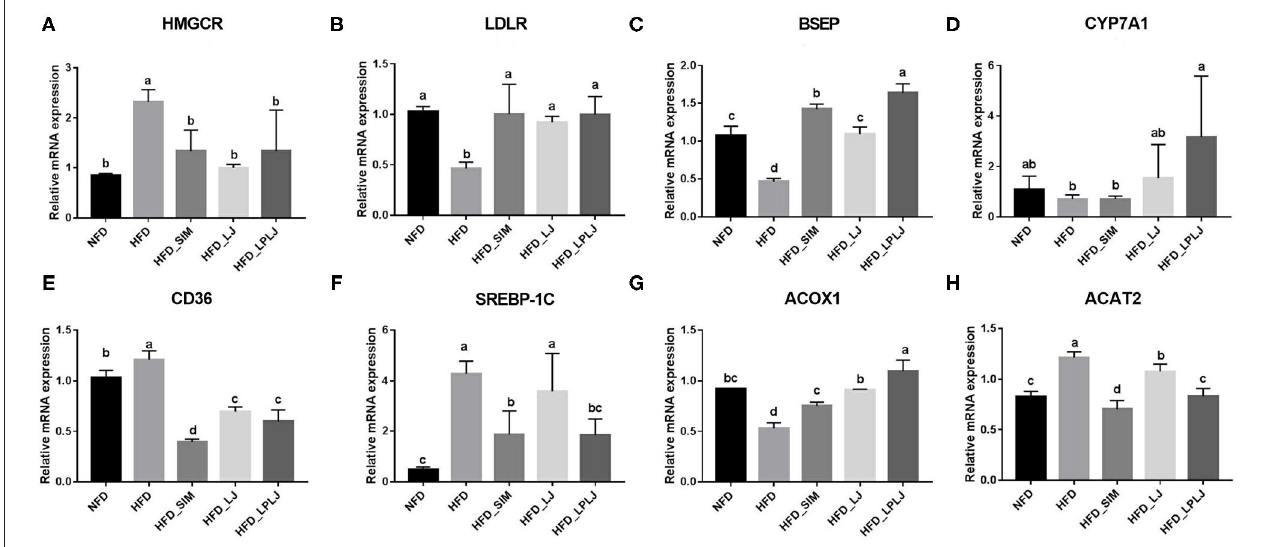
FIGURE 9 | Effects of LPLJ consumption on the expression of hepatic related genes in HFD-fed rats. The bar graphs showed mRNA levels of (A) HMGCR, (B) LDLR, (C) BSEP, (D) CYP7A1, (E) CD36, (F) SREBP-1C, (G) ACOX1 and (H) ACAT2, which were determined by RT-qPCR. a-d, Mean values with different letters in the same column differ significantly ( p <